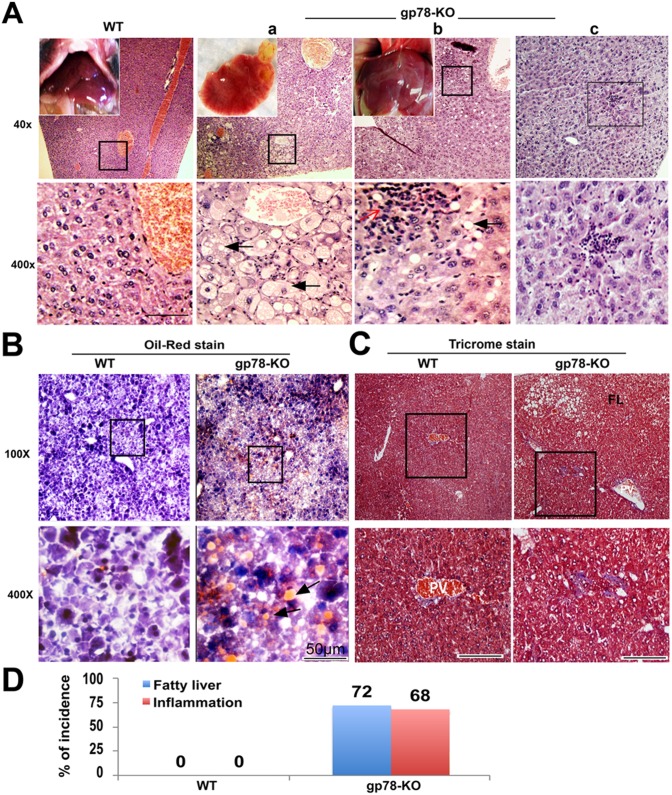
Gp78-KO mice spontaneously develop hepatic steatosis with inflammatory infiltrates.(A) Livers of 1-year-old gp78 KO mice, grown with normal diet were stained with H&E and visualized as indicated magnification. (a) Steatohepatitis shows swelling cytoplasm with lipid droplets (black arrow) and infiltrating cells. (b) Mild lipid droplets and infiltrating cells (Red arrow). (c) Infiltrate cells gather in the absence of lipid droplets. (B) Oil red stain. Arrow indicates lipid droplets. (C) Trichrome stain was preformed to identify blue colored collagen fibers. PV; portal vein, FL; fatty liver area. (D) Percentage of incidence including mild fatty liver, inflammation in 1-year-old KO mice (n = 25 mice per each group).